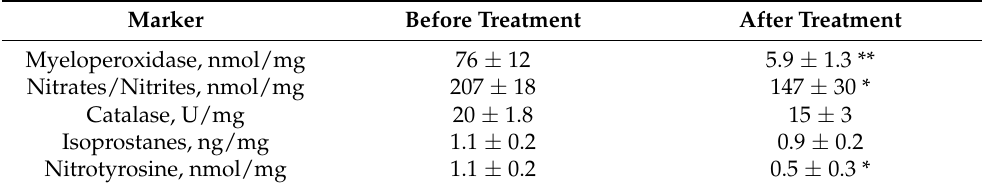
Table 3. Oxidative markers in cervical tissue of CIN I and CIN II patients (n = 50) treated